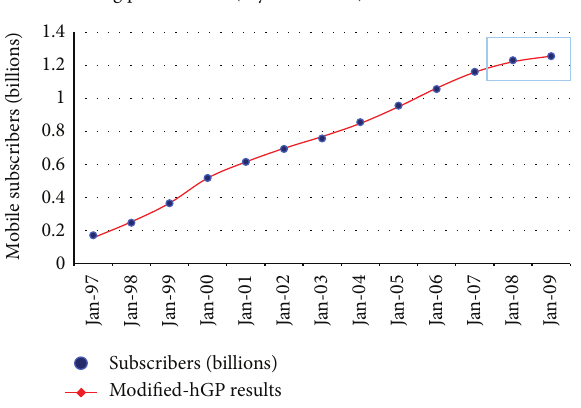
Figure 19: The forecasting performance of modified-hGP (forecast period—2 years ahead).